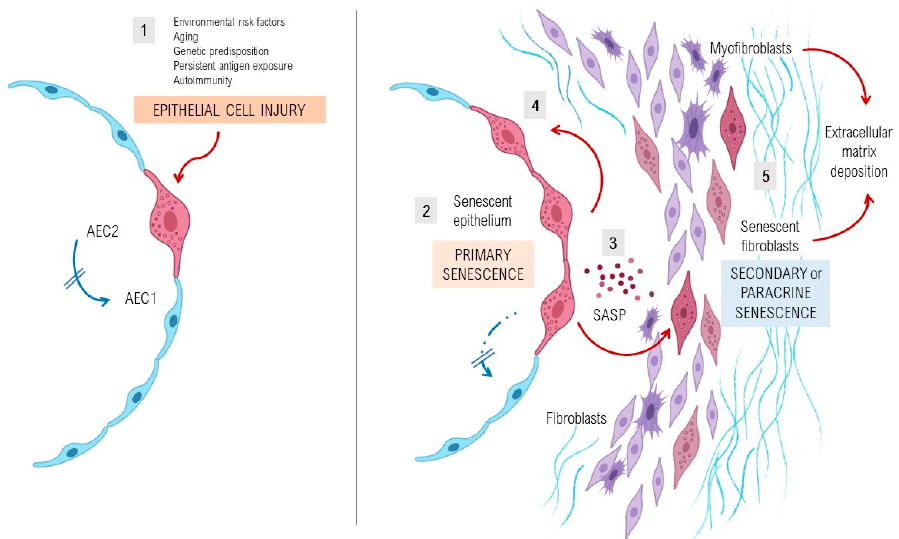
Figure 1. Pathogenesis and perpetuation of fibrosing interstitial lung diseases. Environmental risk factors, age-related cell perturbations, genetic predisposition, persistent exposure to antigens and autoimmune diseases are identified as important factors that increase susceptibility to epithelial lung injury acting as initial triggers of the disease. In an early phase, shown in the left part of the figure (1), epithelial type 2 cells (AEC2) show several markers of stress, activation, and senescence, as they fail to respond to stress resulting in an impaired capacity of the lung to regenerate. In a later phase, and especially after repeated alveolar damage, sustained aberrant activation and senescence of the epithelium (2) leads to the hyperactive secretion of high levels of pro-fibrotic growth factors, cytokines, chemokines and matrix metalloproteinases, collectively known as senescence-associated secretory phenotype (SASP) factors (3), that promote cellular senescence of the adjacent AEC2 (4). This initial event is encompassed in a process called primary senescence, which is thought to be characterized by the appearance of a senescent lung epithelium which persists by adapting its metabolic pathways and becoming resistant to apoptosis. In this later phase, a dysregulated crosstalk between the senescent epithelium and the mesenchymal cells through SASP factors will give rise to the accumulation of fibroblasts and myofibroblasts, resulting in an increased production and deposition of extracellular matrix components (5). A considerable part of fibroblasts and myofibroblasts will present a stressed and senescent phenotype, including resistance to apoptosis, which entails a process called secondary or paracrine senescence. As a consequence, in the context of senescence in lung injury and repair, the accumulation of extracellular matrix components in the interstitium of the lung will lead to lung fibrosis.